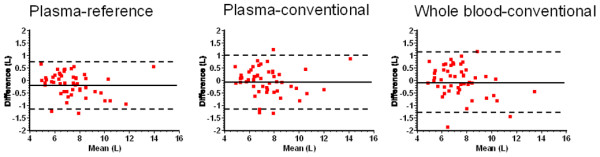
Bland–Altman plots of the differences between each approximated IDVG and original IDVG. Approximated IDVG was calculated from a formula using the increased glucose concentration above baseline at 3 min after injection of glucose [9]. Shown are the reference plasma glucose measurement (left), a conventional plasma glucose measurement (middle) and a conventional whole blood measurement (right). Solid lines represent the mean difference, and dashed lines represent the 95% confidence interval.